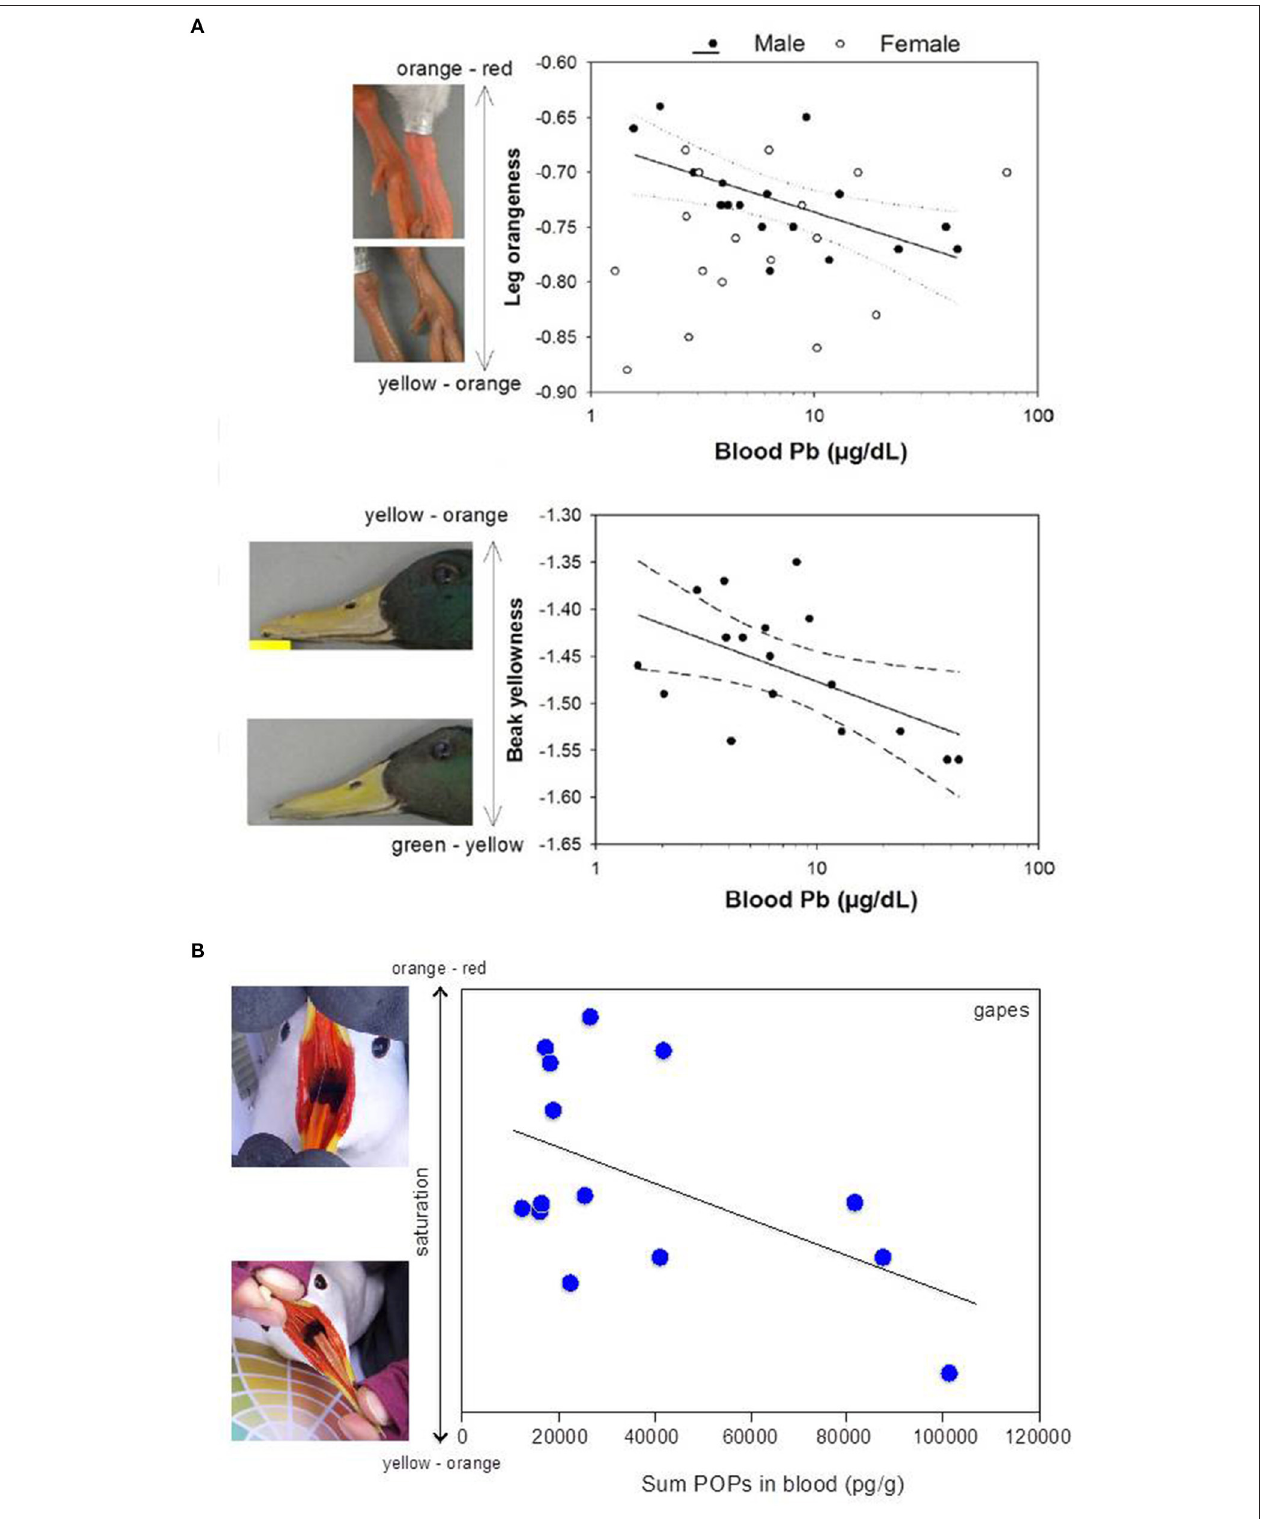
FIGURE 1 | (A) Wild male mallards ( Anas platyrhynchos ) exposed to high concentrations of lead (Pb) had paler carotenoid-based colorations in both legs and beak. Reprinted from Vallverdú-Coll et al. (2016) with permission from John Wiley and Sons; (B) Wild female black-legged kittiwakes ( Rissa tridactyla ) with higher blood concentrations of persistent organic pollutants (POPs) had paler carotenoid-based colorations in the gapes. Modified from Blévin et al. (2014). Photographs were courteously provided by Frédéric Angelier.